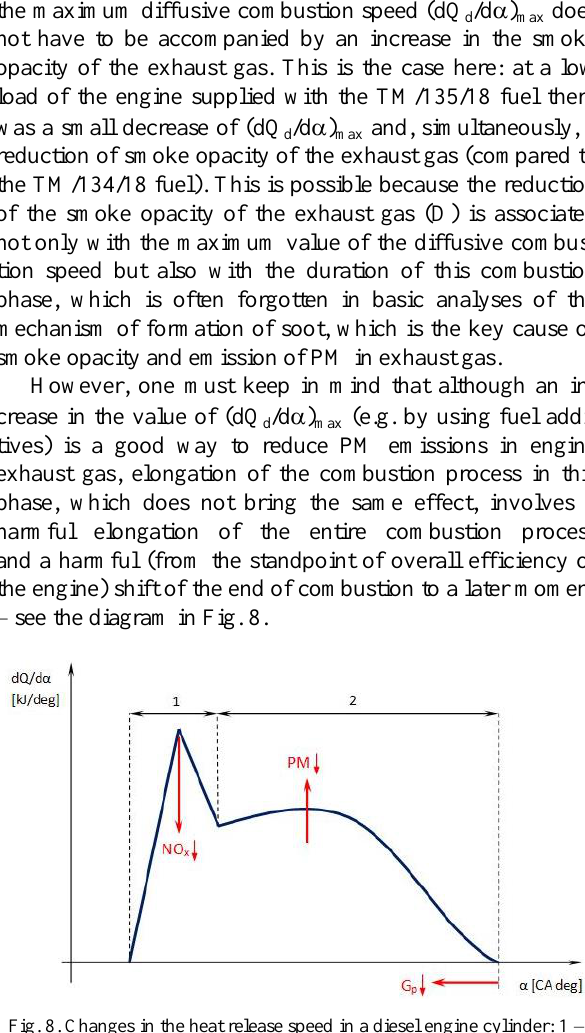
Fig. 8. Changes in the heat release speed in a diesel engine cylinder: 1 – kinetic combustion speed phase, 2 – diffusive combustion speed